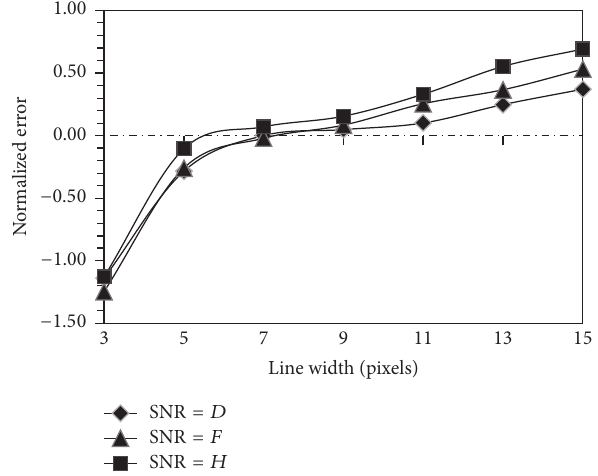
Figure 15: Normalized error level for different image SNRs and various line